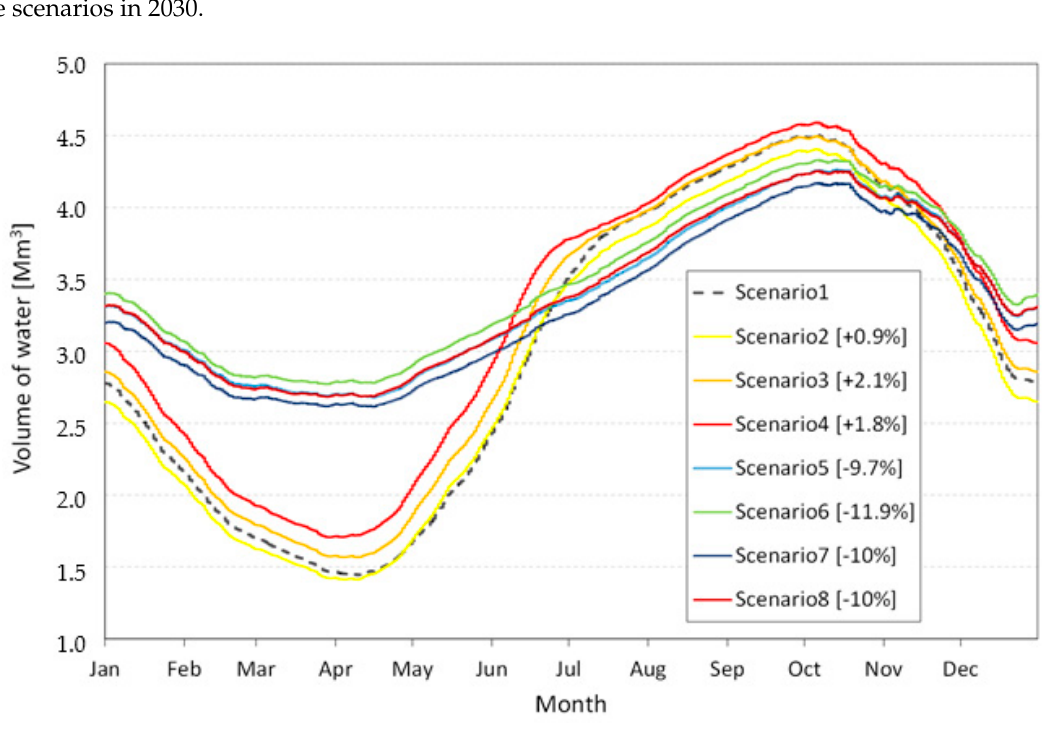
Figure 5. Evolution of the reservoir’s volumes in 2030 for all climate scenarios, with a 95% confidence interval. The mean income variation relative to scenario 1 is shown for all scenarios.